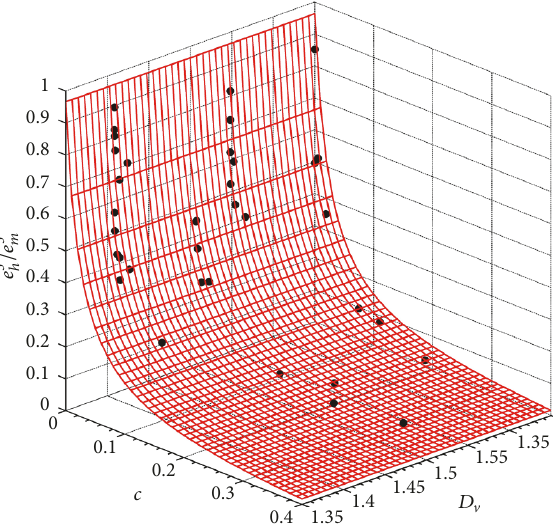
Figure 15: NOF values of hydraulic aperture for the fracture specimens evaluated by different models.